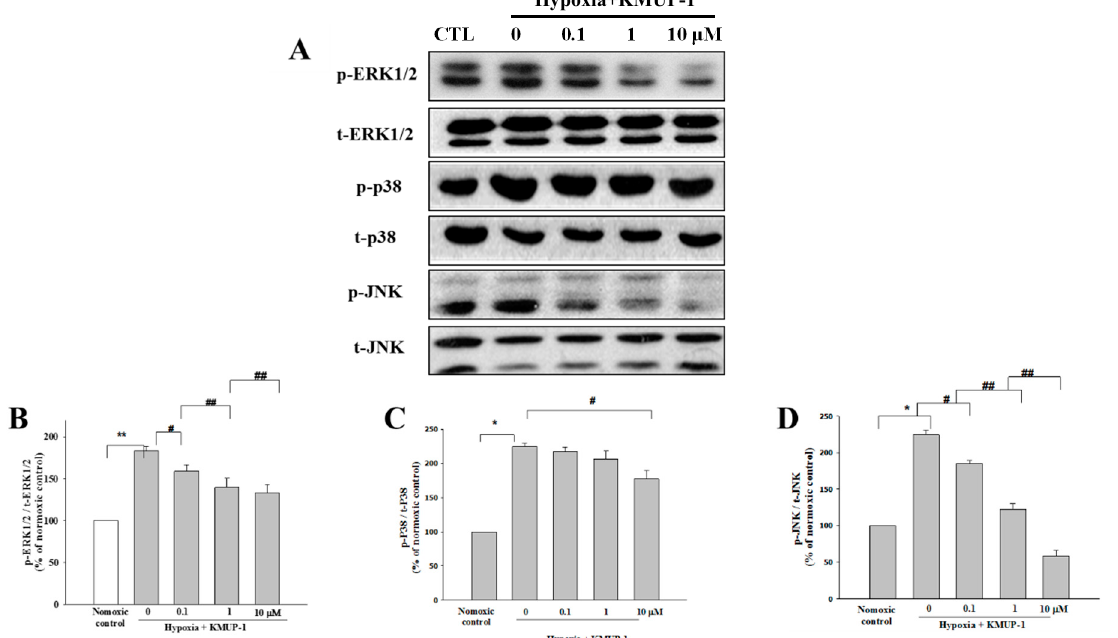
Figure 7 . Effects of KMUP-1 on ERK1/2, p38, and JNK protein expressions in hypoxic H9c2 cell. ( A ) Western blot analyses of these proteins were performed on whole protein extracts from H9c2 cardiomyoblasts during hypoxia (24 h). Quantitative analysis protein expression of ( B ) ERK1/2, ( C ) p38, and ( D ) JNK. Results are presented as mean ± SEM from three independent experiments. * p < 0.05 vs. normoxic control, # p < 0.05 vs. hypoxic control, ## p < 0.01 vs. hypoxic control.